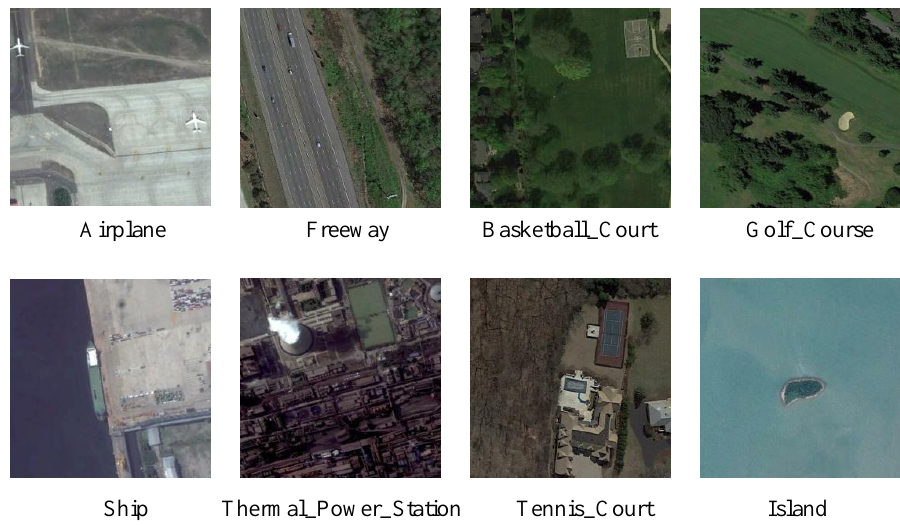
Figure 1. Examples from the NWPU-RESISC 45 dataset. The small objects in the images are critical to the classification of the